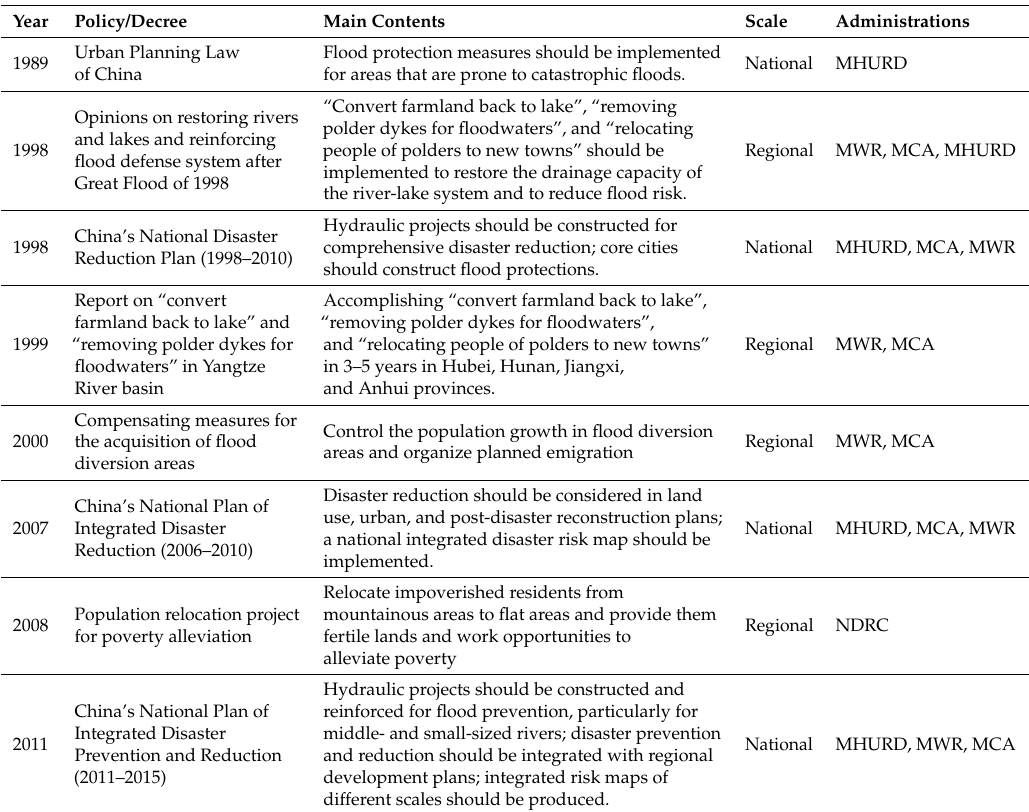
Table 2. Major policies related to the population in floodplain (PopF) in China during 1989–2011. (Expanded from